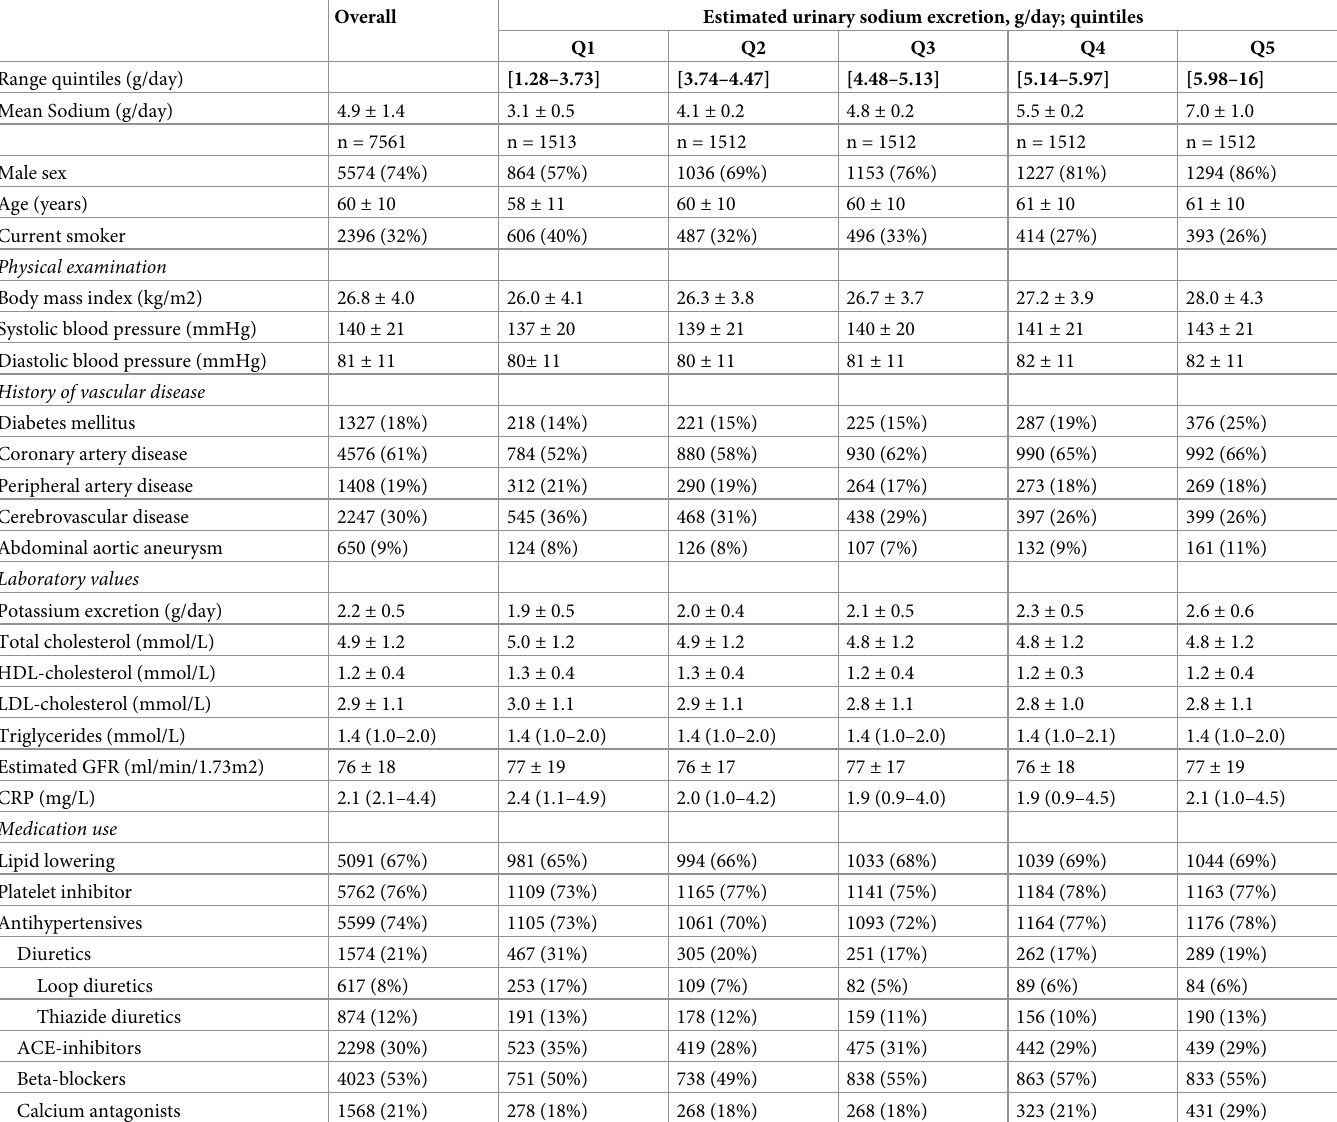
Table 1. Baseline characteristics of all participants, according to estimated 24-hour sodium